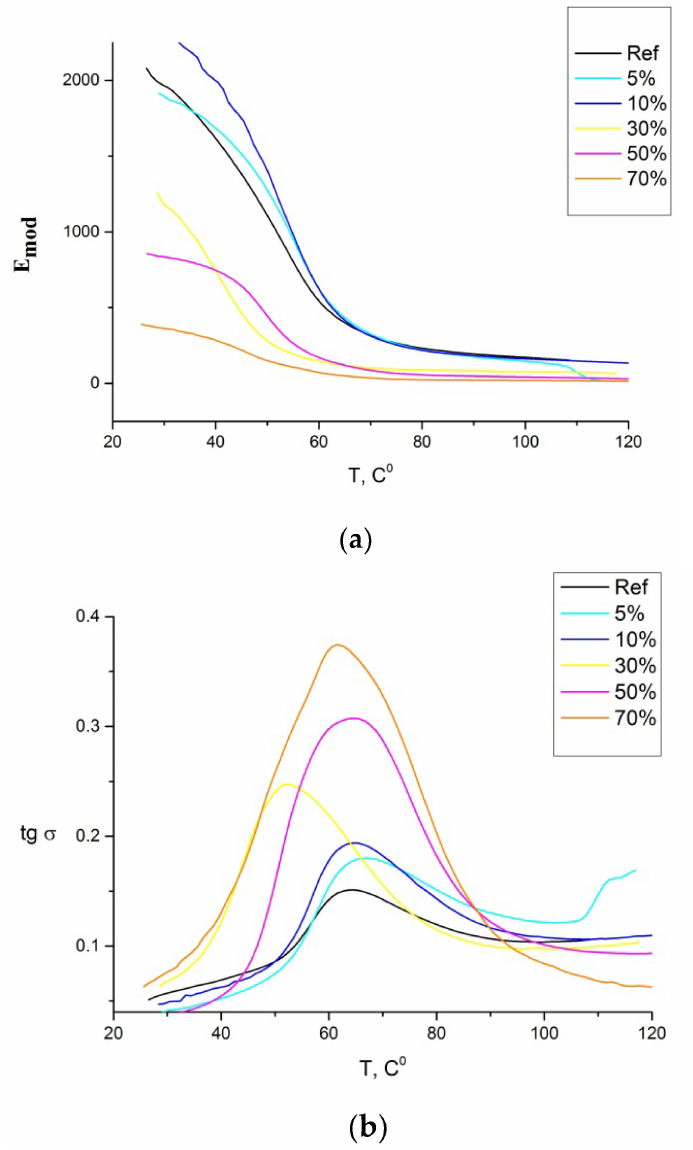
Figure 6. Viscoelastic behavior of pristine PLA and PLA + OTOA (5–70%) film samples: ( a ) elastic modulus, ( b ) mechanical loss tangent (tan δ